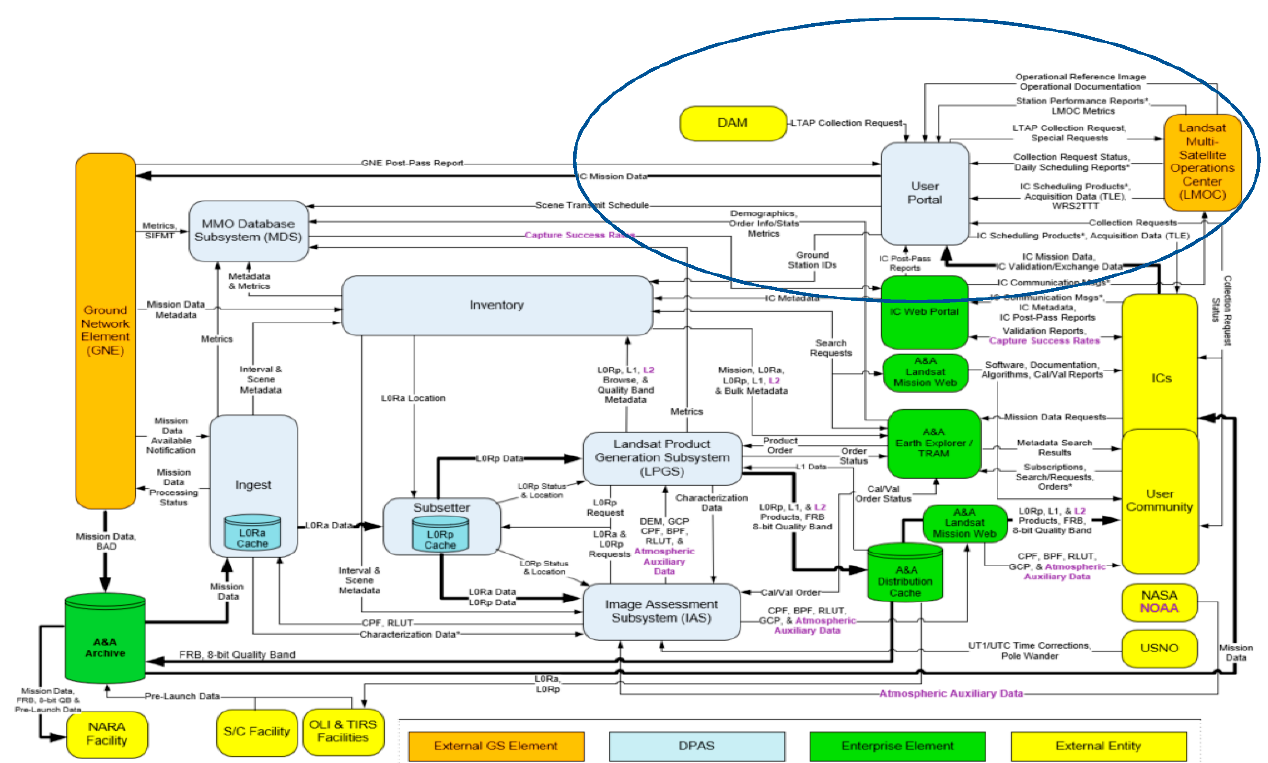
Figure 7. Landsat 9 User Portal Elements Release 7.0.0 Test Subsystems and Interfaces (GNE-Ground Network Element, IC-International Cooperator, DAM-Data Acquisition Manager, SIFMT-Scene to Interval to File Mapping System, L0Ra-Level 0 Reformatted Archive, L0Rp-Level 0 Reformatted Product, A&A-Archive and Access, TRAM-Tracking, Routing and Metrics, FRB-Full Resolution Browser, CPF-Calibration Parameter File, BPF-Bias Parameter File, RLUT-Response Linearization Look Up Ta- ble, GCP-Ground Control Point, USNO-U.S. Naval Observatory, TLE-Two Line Element, L1-Level 1, L2-Level 2, S/C-Spacecraft, GS-Ground Systems, DPAS-Data Processing and Archive